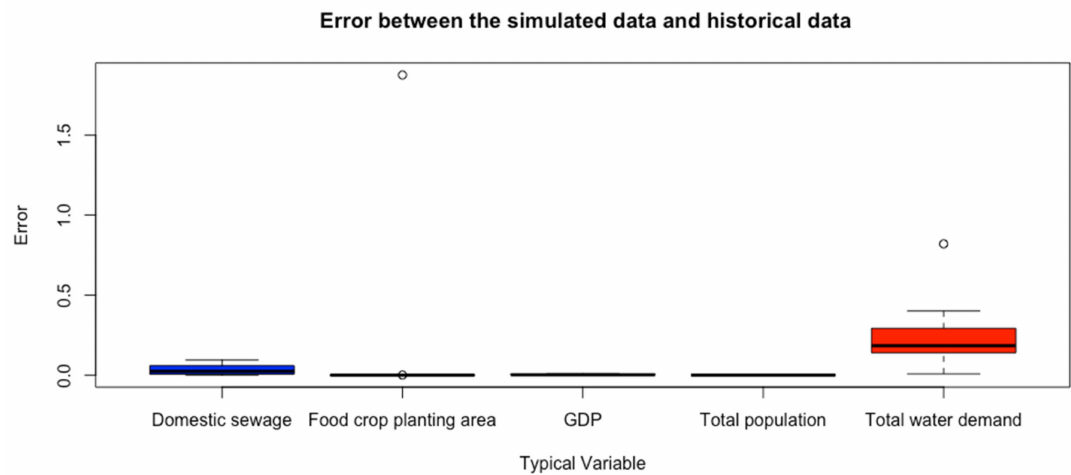
Figure 6. Historical examination result of the WEF nexus SD